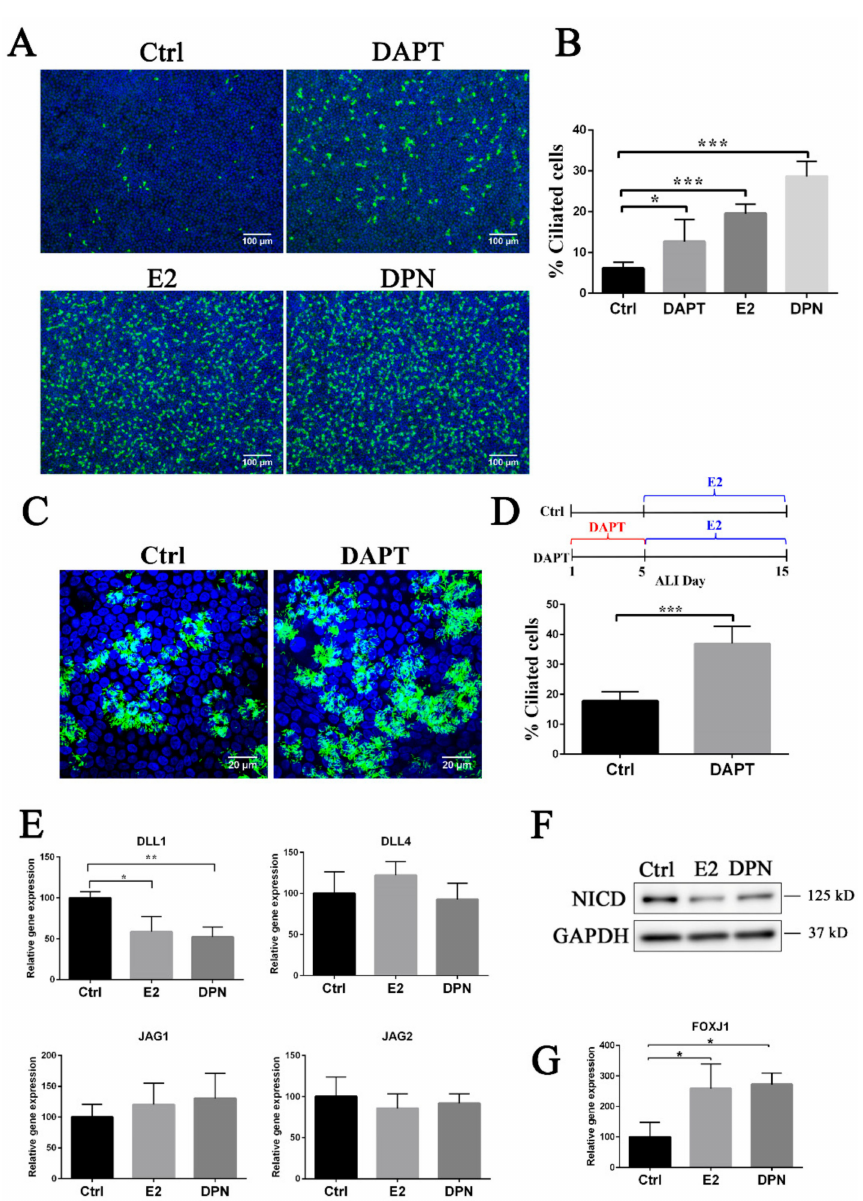
Figure 4. Estrogen regulated Notch signaling by suppressing DLL1 in ciliogenesis. ( A ) FTECs were cultured in basal medium (Ctrl) or with DAPT (10 µ M), E2 (2 ng / ml), and DPN (100 nM) for ALI 10 days. Cells were stained for ac-tubulin (green) and nuclei (blue). Scale bars: 100 µ m. ( B ) The numbers of ac-tubulin-positive cells were quantified (unpaired t -test, n = 7). ( C ) FTECs were cultured with or without DAPT (10 µ M) for the first ALI 5 days, followed by E2 treatment (2 ng / mL) in both cells for another 10 days. Cells were stained for ac-tubulin (green) and nuclei (blue). Scale bars: 20 µ m. ( D ) The numbers of ac-tubulin-positive cells were quantified (unpaired t -test, n = 7). ( E, G ). qRT-PCR for DLL1 , DLL4 , JAG1 , JAG2 , and FOXJ1 in FTECs that were cultured for 24 h with or without 2 ng / mL E2 or 100 nM DPN (ANOVA test, n = 3). ( F ) Western blot analysis for NICD and GAPDH proteins in FTECs that were treated with E2 or DPN for 8 days in ALI. Significance level: * p < 0.05, ** p < 0.01, and *** p <